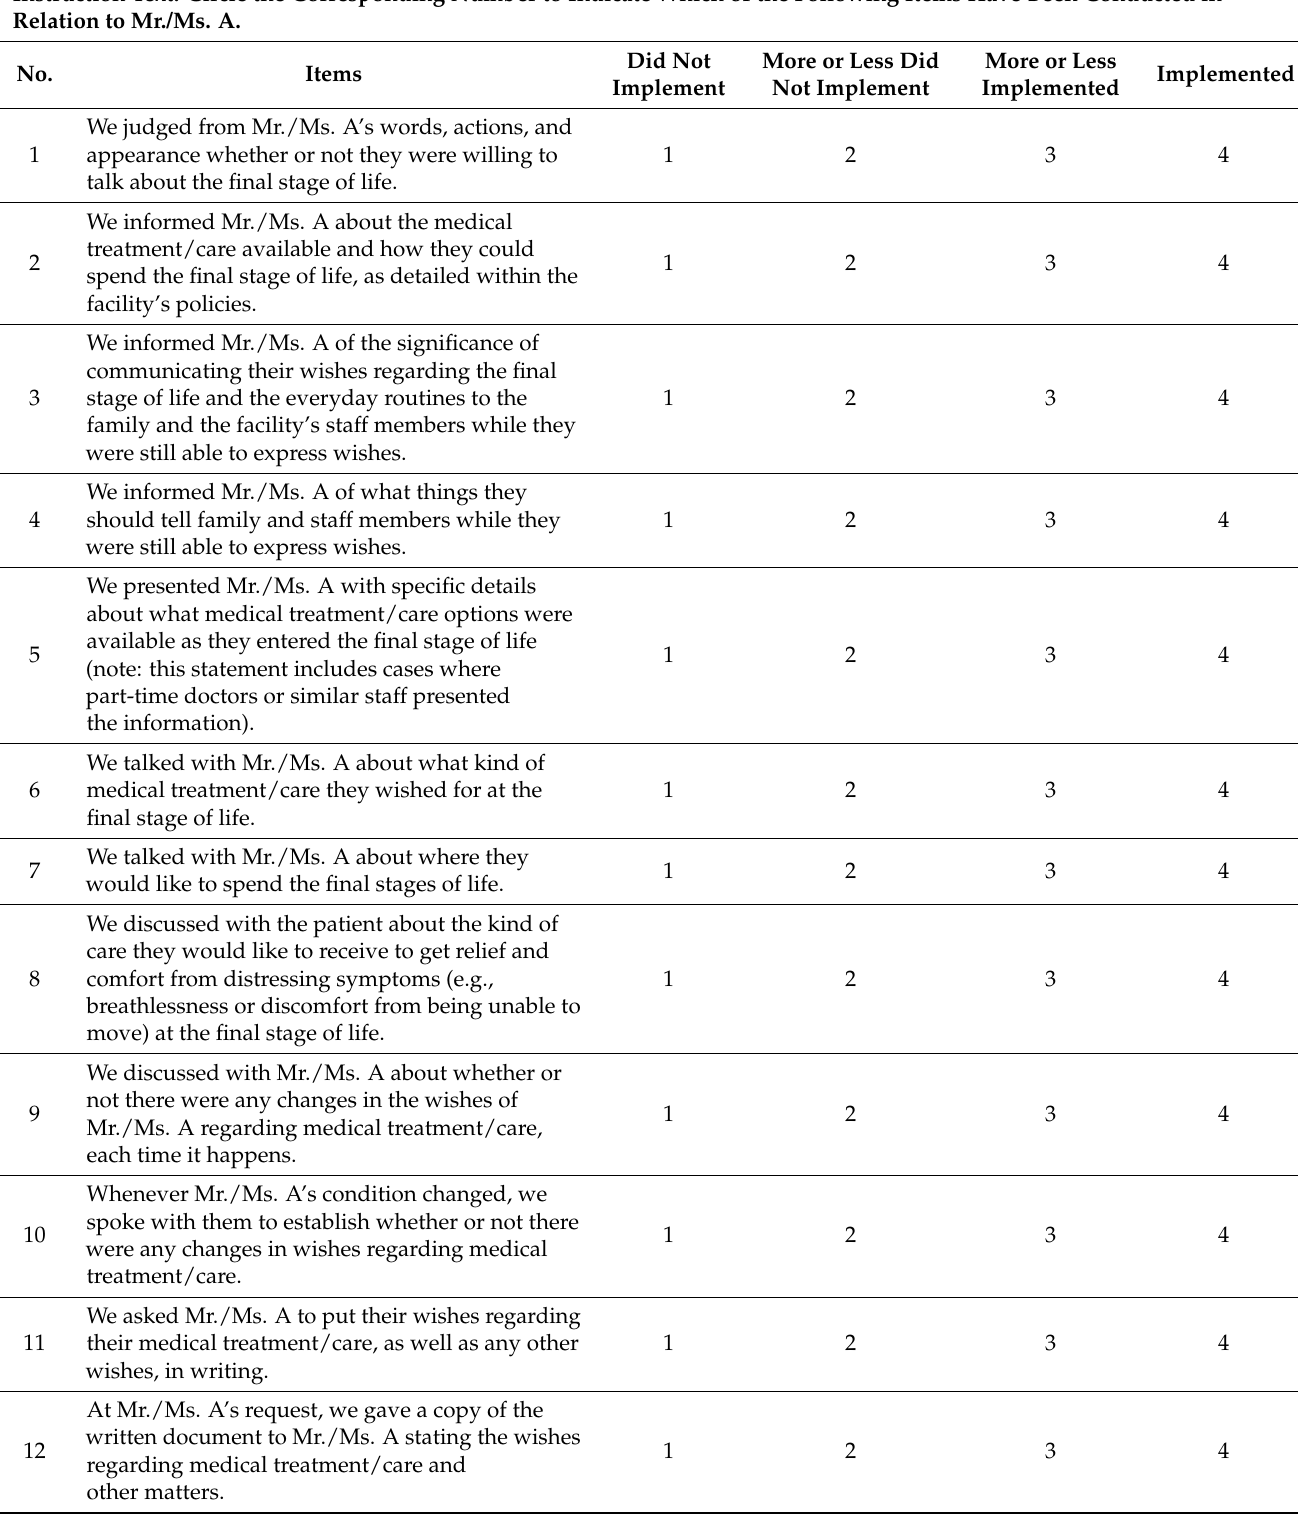
Table 5. The final version of Advance Care Planning Practice Inventory